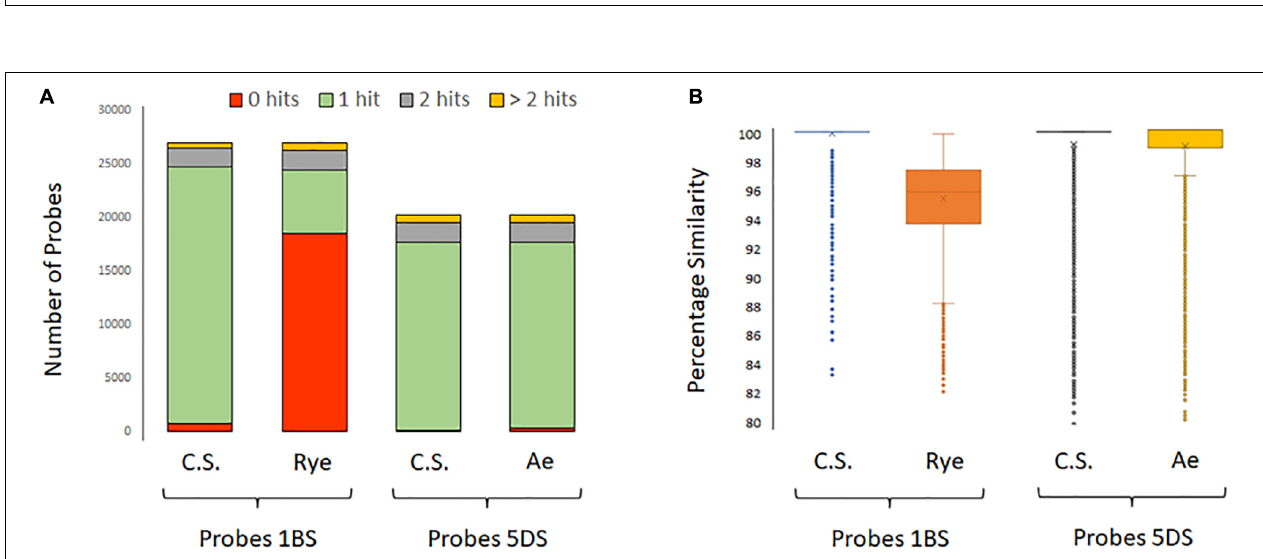
FIGURE 4 | (A) Bar graphs showing the number of capture probes that had BLAST hits to ‘Chinese Spring’ chromosome 1BS (IWGSC v1), S. cereale chromosome 1RS (JADQCU000000000 v1 of the cultivar Weining), ‘Chinese Spring’ chromosome 5DS (IWGSC v1), and Ae. tauschii chromosome 5DS (PRJNA341983 assembly of Ae. tauschii subsp. strangulata ). The number of probe sequences for chromosomes 1BS and 5DS was 26,985 and 20,253, respectively. The number of probes that produced a hit was 26,222 to ‘Chinese Spring’ 1BS, 8,419 to S. cereale 1RS, 20,082 to ‘Chinese Spring’ 5DS, and 19,872 to Ae. tauschii 5DS. There were more hits than probe sequences as some probes had multiple hits. (B) Box and whisker plots showing the percentage similarity between the probe sequences and their respective targets.